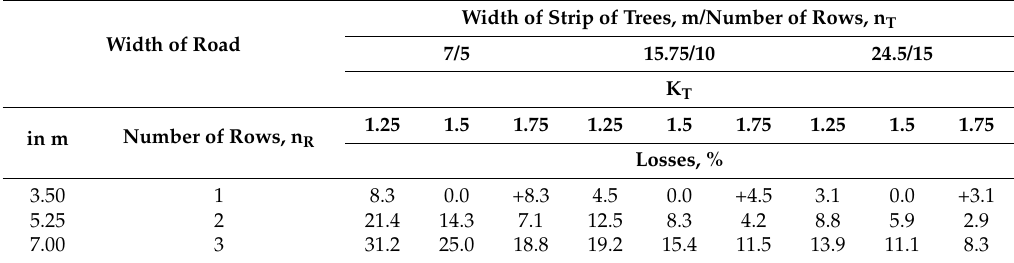
Table 5. Estimation of productivity losses depending on width of strip road and width of strip of trees. Width of Strip of Trees, m/Number of Rows, n T Width of Road 7/5 15.75/10 24.5/15 K T in m Number of Rows, n